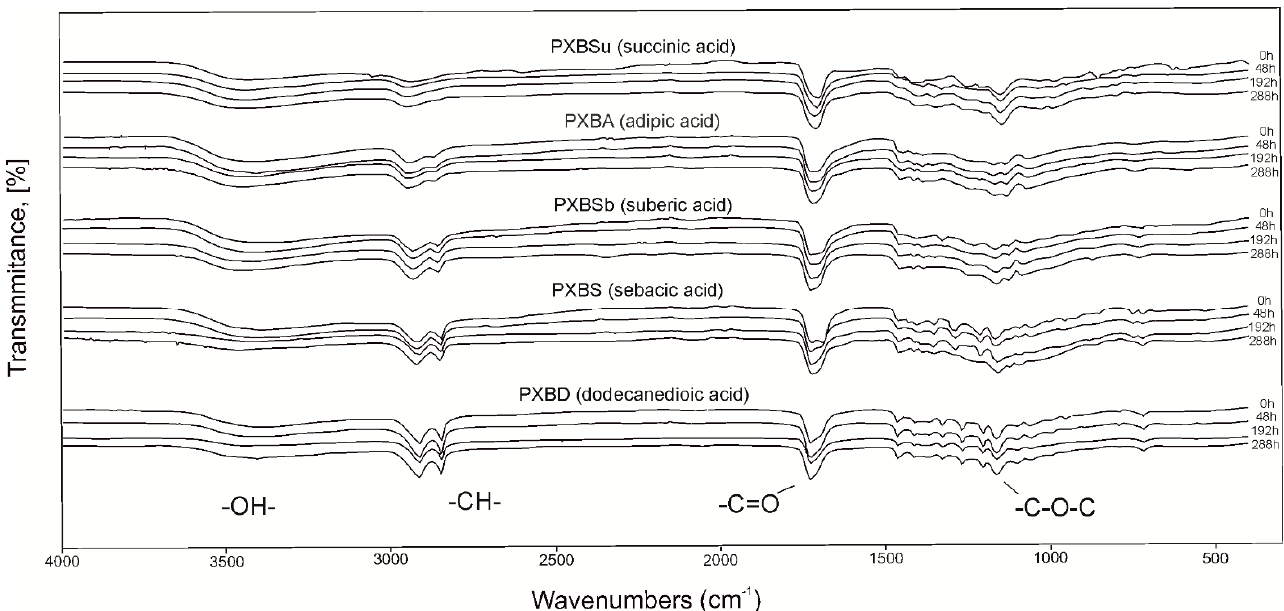
Figure 4. FTIR spectra of PXBSu, PXBA, PXBSb, PXBS, and PXBD prepolymers (0 h) and polymers at consecutive stages of cross-linking process (48 h, 144 h, 192 h and 288h).